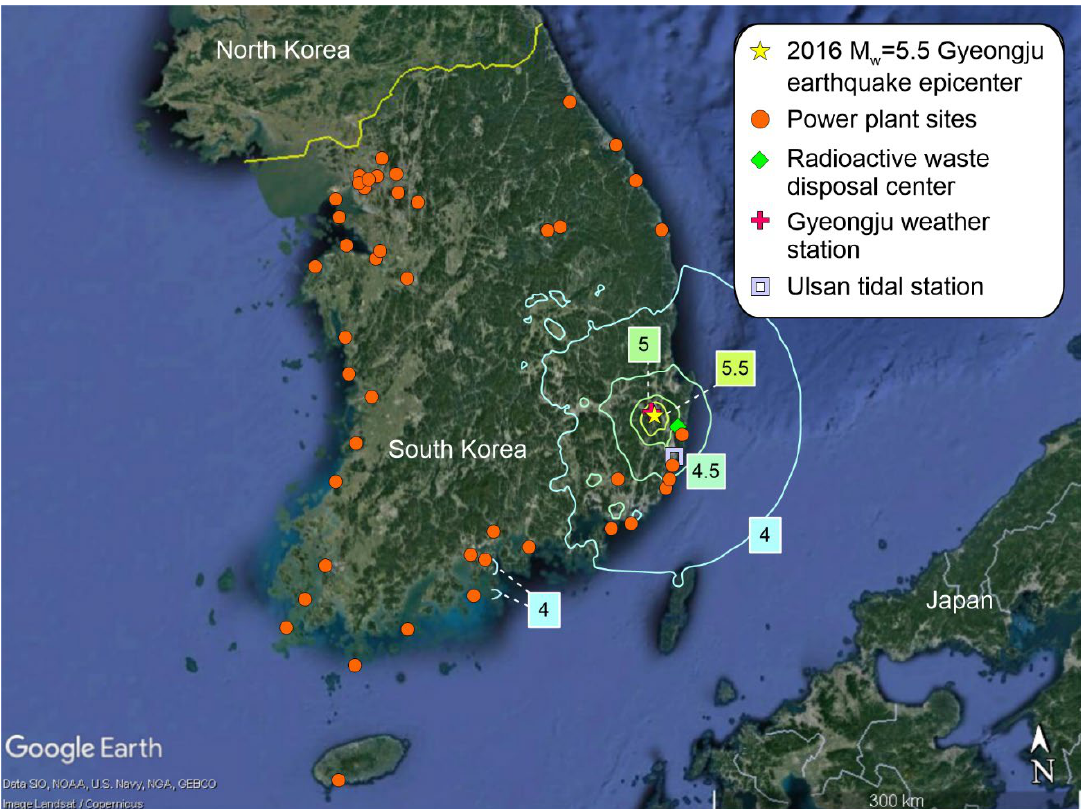
Figure 1. Map of South Korea showing locations of major thermal and nuclear power plant sites as well as the Wolseong Low and Intermediate Level Radioactive Waste Disposal Center. The 2016 Gyeongju earthquake epicenter is also shown, along with MMI earthquake intensity contours. Recreated and modified from [16,22].